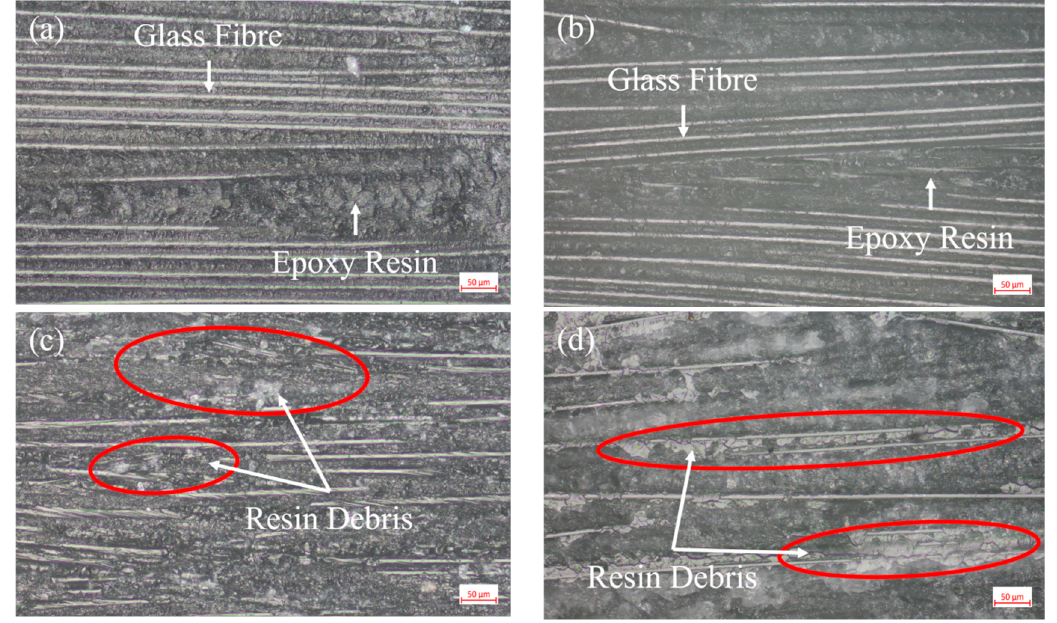
Figure 9. Photomicrograph of the failure surfaces of DCB sample: ( a ) GF/EP infusion sheets that have not undergone flame treatment; ( b ) GF/EP pultruded sheet that has not undergone flame treatment; ( c ) GF/EP infusion sheet after five flame treatments; ( d ) GF/EP pultruded sheet after five flame treatments.